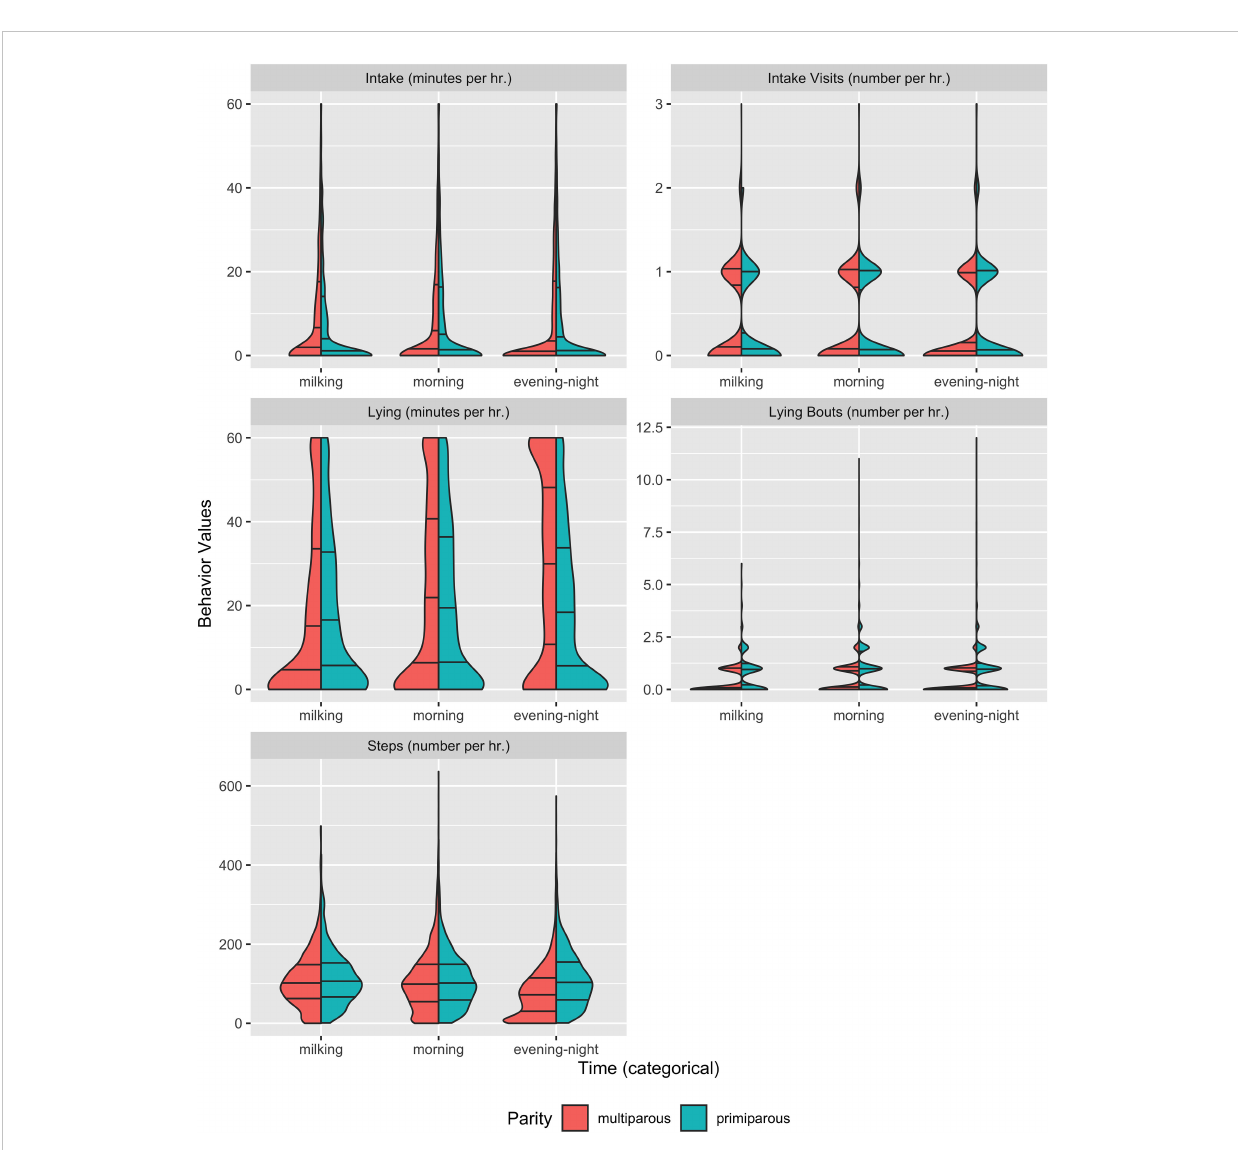
FIGURE 1 Distribution and density of raw sensor data strati fi ed by parity and time of the day for the fi ve behaviors registered by a leg-attached 3-axis accelerometer (TrackaCow, ENGS, Hampshire, UK). Horizontal lines indicate mean and standard deviation. Milking is from 4:00 to 5:59 h and